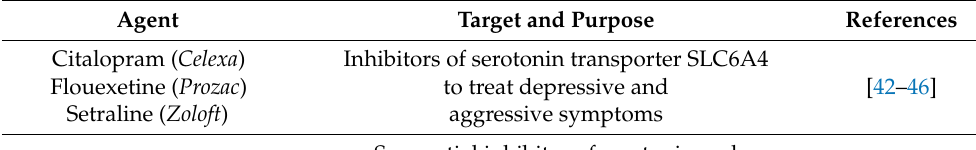
Table 1. Palliative interventions used in HD treatment. Agent Target and